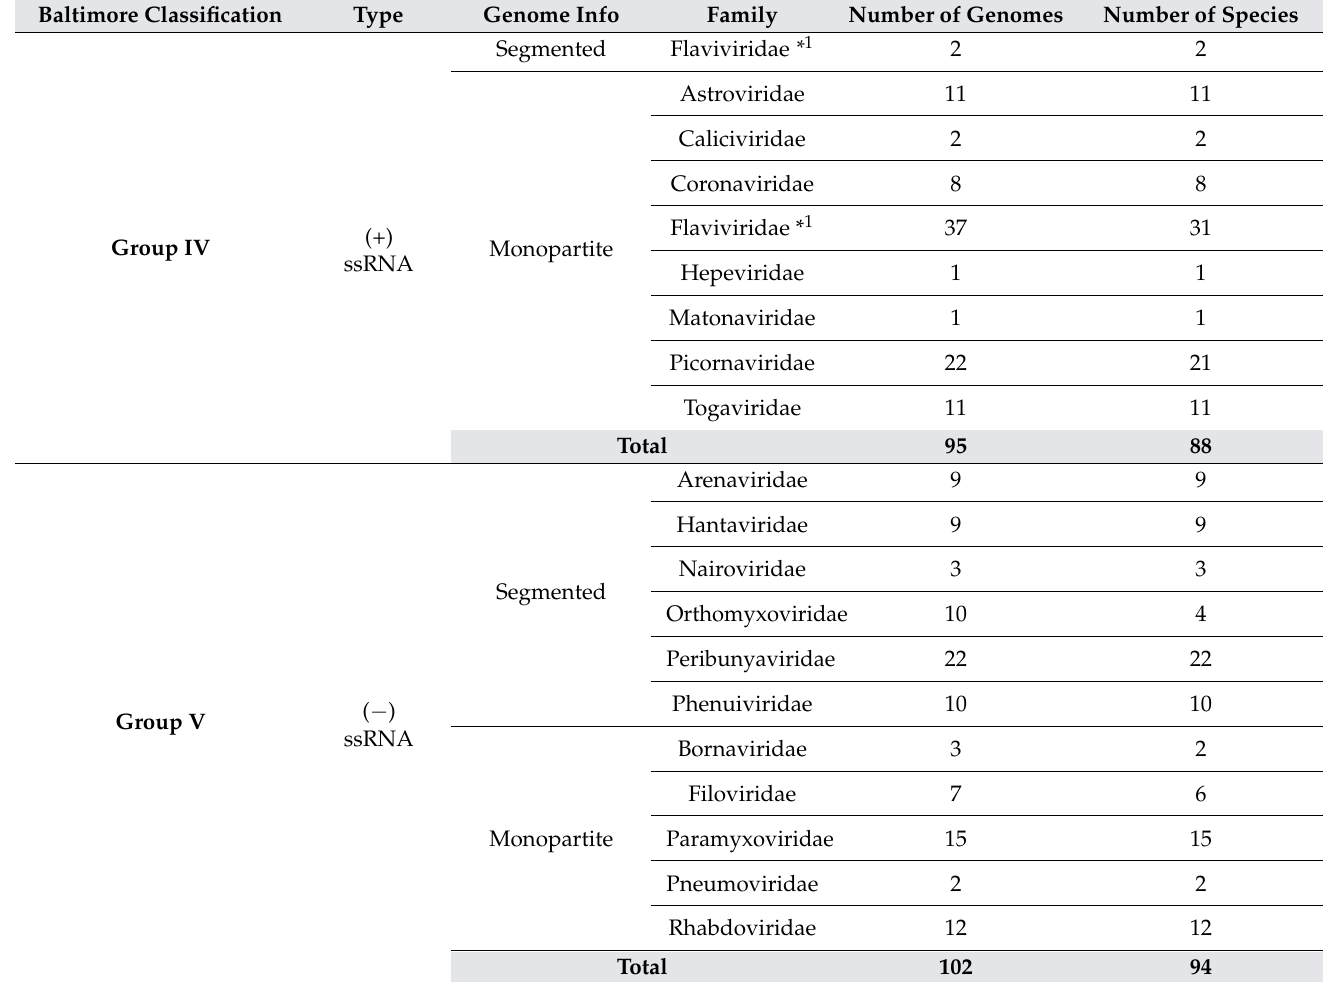
Table 1. Viral classes and families as well as the number of species and genomes considered within this